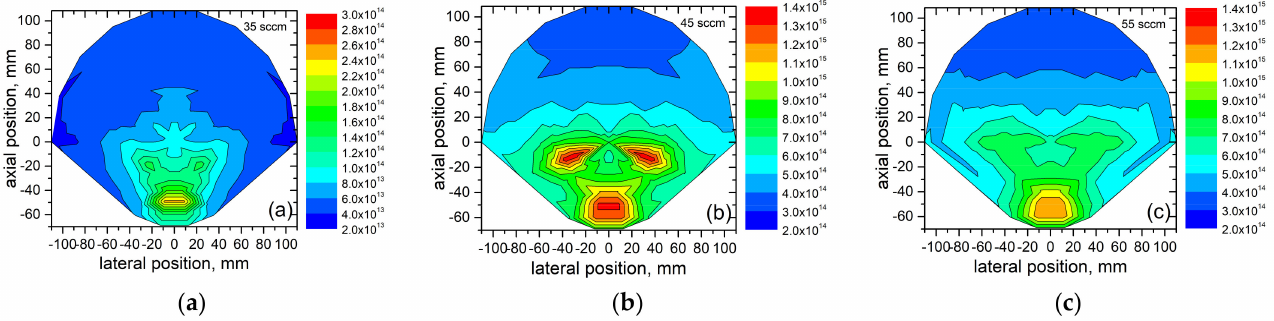
Figure 12. Measurement results for electron density. ( a )—35 sccm; ( b )—45 sccm; ( c )—55 sccm. Axial positions are given relative to the rotation axis of the linear stage. Thruster cut-off is situated at the position − 70